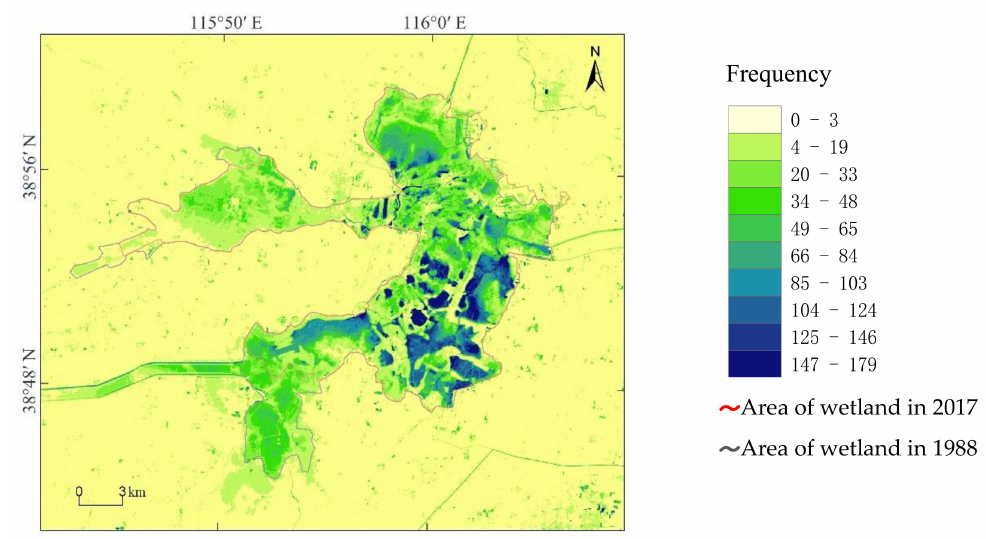
Figure 6. The time cumulative frequency of open water during 34 years from 1984 to 2017 derived from the cumulation of open water extracted in 190 temporal scenes, where the red polyline and black polyline is the area of wetland in 1989 and 2017,